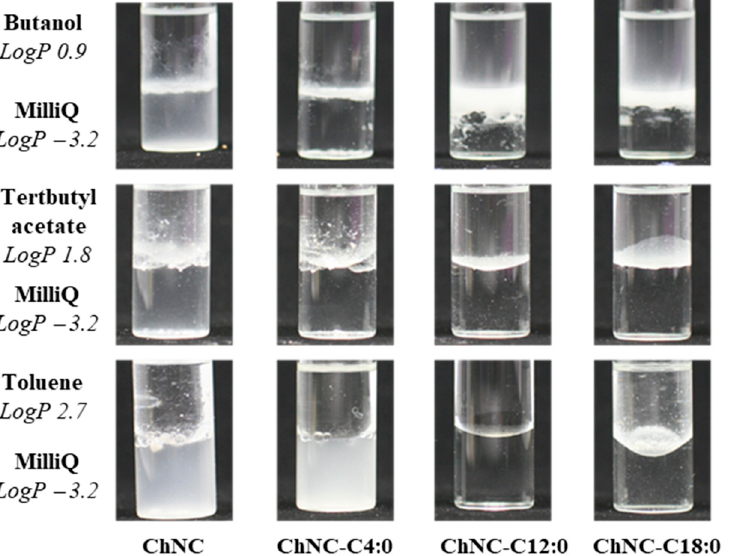
Figure 4. Phase behavior of (un)modified ChNC in two-phase systems, indicative of their hydro- phobicity.